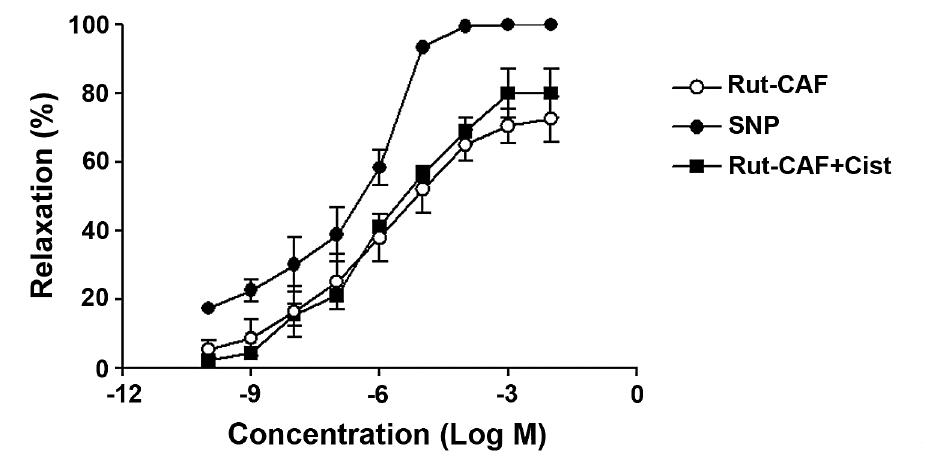
Figure 3 – Effect of LLNO1 alone and in combination with L-Cysteine (L-Cyst) upon rabbit aortic rings. The rings were precontracted with 1 µ M phenylephrine and relaxation concentration/response curves (concentrations graded from 10 -12 to 10 -3 M) were plotted for LLNO1 alone and in combination with 100 µ M L-Cyst. Findings are expressed as average ± standard error, based on six experiments. p > 0.05 vs. LLNO1 + L-cyst, SNP, LLNO1 (ANOVA followed by the Tukey-Kramer test).